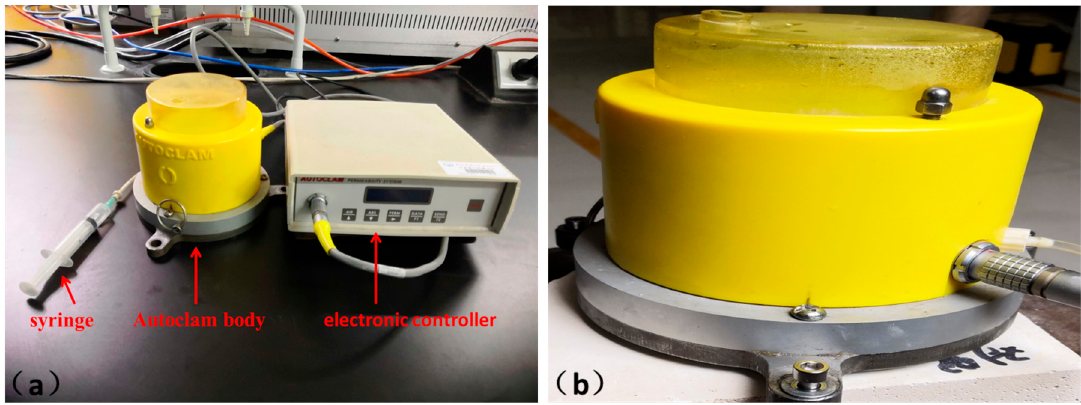
Figure 3. Autoclam permeability system. ( a ) Syringe for applying air pressure, autoclam body an delectronic controller. ( b ) The sample being tested